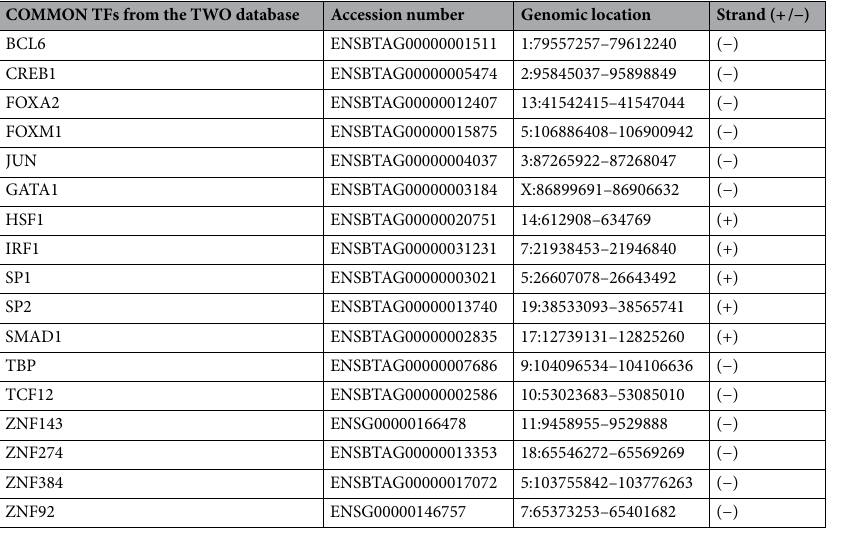
Table 5. List of transcription factors predicted by AnimalTFDB and GeneXplain, their genomic location and strands.